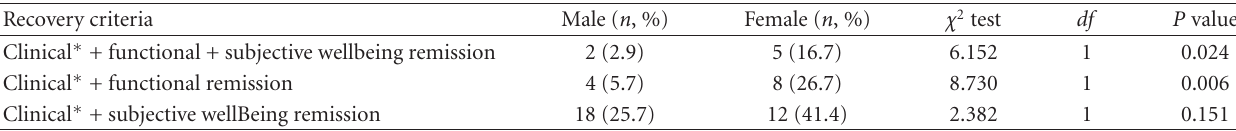
Table 5: Recovery rates according to